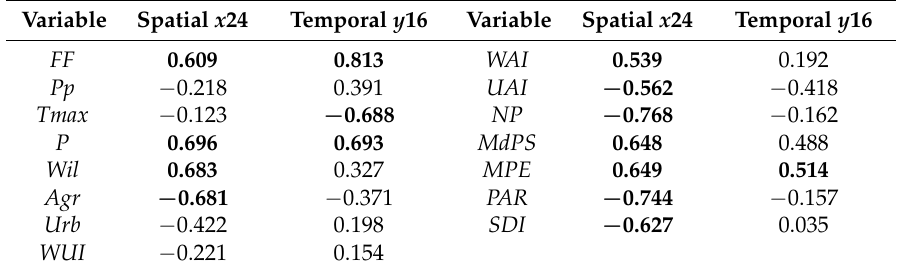
Table 3. Pearson product-moment correlation coefficient between each variable of Table 1 and the descriptors of spatial and temporal aggregation. In bold, values over